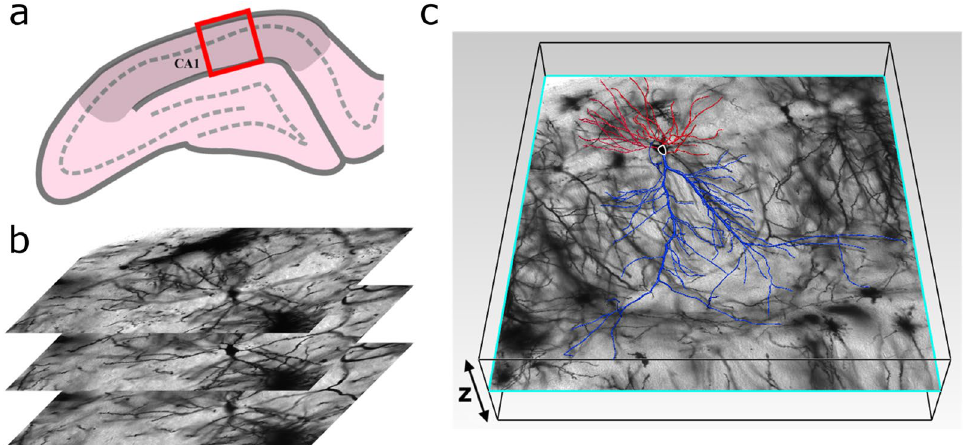
Figure 6. ( a ) Schematic diagram of a coronal slice through the hippocampus at Bregma −4.52 mm showing the collection region (red box) within hippocampal CA1 (darkened area); the somata layer is denoted by the dashed line. ( b ) Confocal micrographs of Golgi-Cox stained cells. Three 774 by 774 µm cross-sections separated by 2 µm in the z-direction are shown. ( c ) A model showing a neuron’s soma (outlined in white) as well as its basal (red) and apical (blue) dendritic arbors superimposed on the original micrograph. The image in ( c ) was generated using Neurolucida.